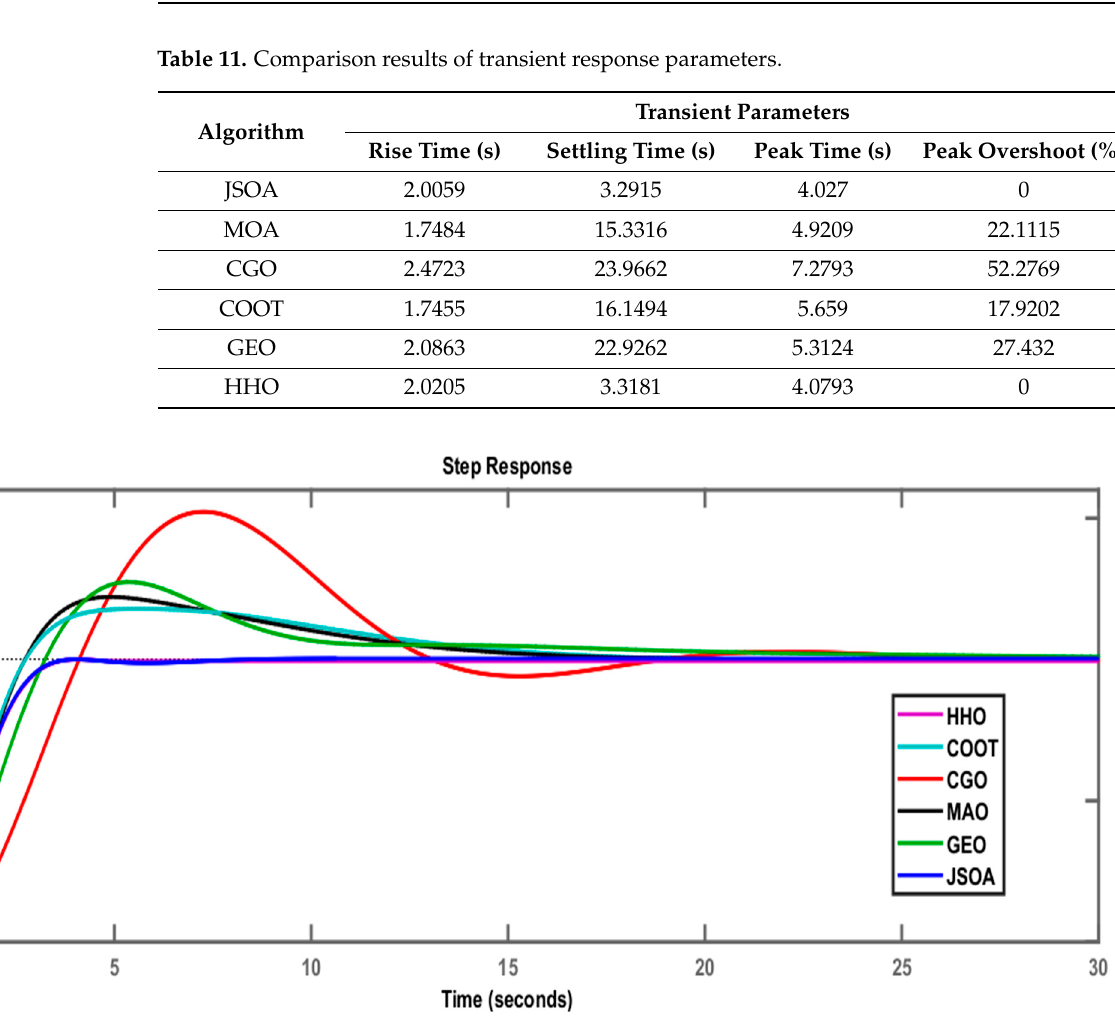
Figure 16. Comparative results of step response for the PID controller.